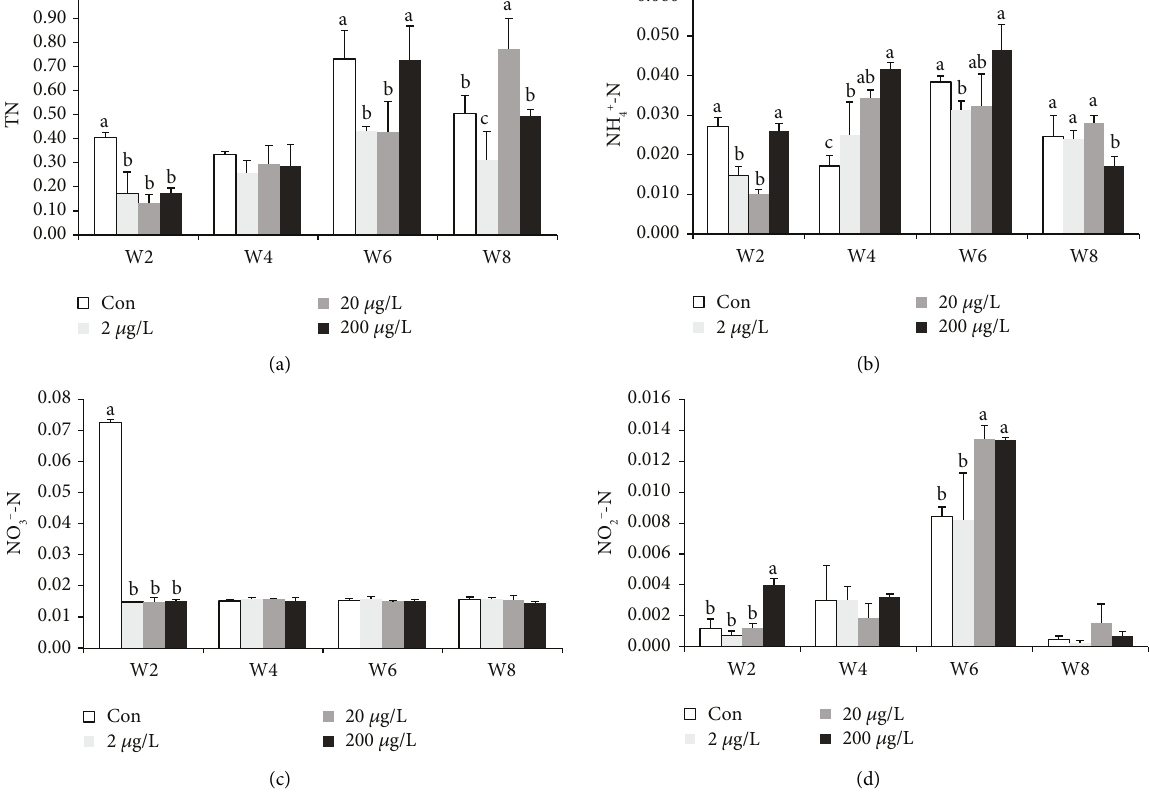
Figure 1: The water quality indexes in experimental tanks during different weeks. Total nitrogen (TN) (a), ammonia (NH 4+ -N) (b), nitrate (NO 3 - -N) (c), and nitrite (NO 2 - -N) (d) were revealed with the unit of mg/L. The treatment for 0, 2, 20, and 200 μ g/L METin triplicate (n � 12 total tanks for 4 groups and n � 15 individuals per tank in triplicate).